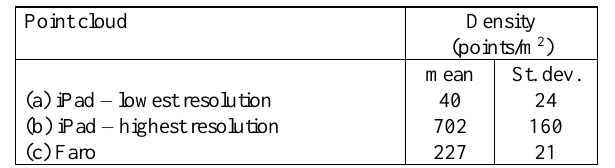
Table 4 . Mean and standard deviation of the density (number of neighbours) in 1 m 2 for a single TLS scan and the two resolutions of the single iPad scans.